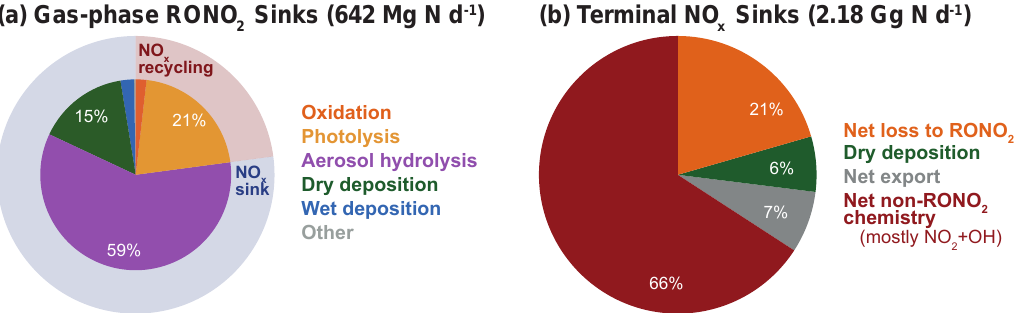
Figure 11. Simulated relative importance of gas-phase loss processes (%) in the Southeast US boundary layer (80–94.5 ◦ W, 29.5–40 ◦ N, < 2km) during August–September 2013 for (a) gas-phase RONO 2 and (b) NO x . In (a) , outer circles group losses into those that recycle NO x (pale red) and those that serve as terminal NO x sinks (pale blue). Loss processes that recycle RONO 2 by converting between RONO 2 species (e.g., first to second generation) are not included. In (b) , net loss to RONO 2 is calculated as the difference between NO x consumed during RONO 2 production and NO x recycled during RONO 2 loss, with recycling efficiencies from (a) . Net non-RONO 2 chemistry is the difference between NO x chemical production and chemical loss excluding all RONO 2 chemistry, and net export is the difference between emissions and all other sinks. Absolute loss rates from all processes combined are given in the sub-plot